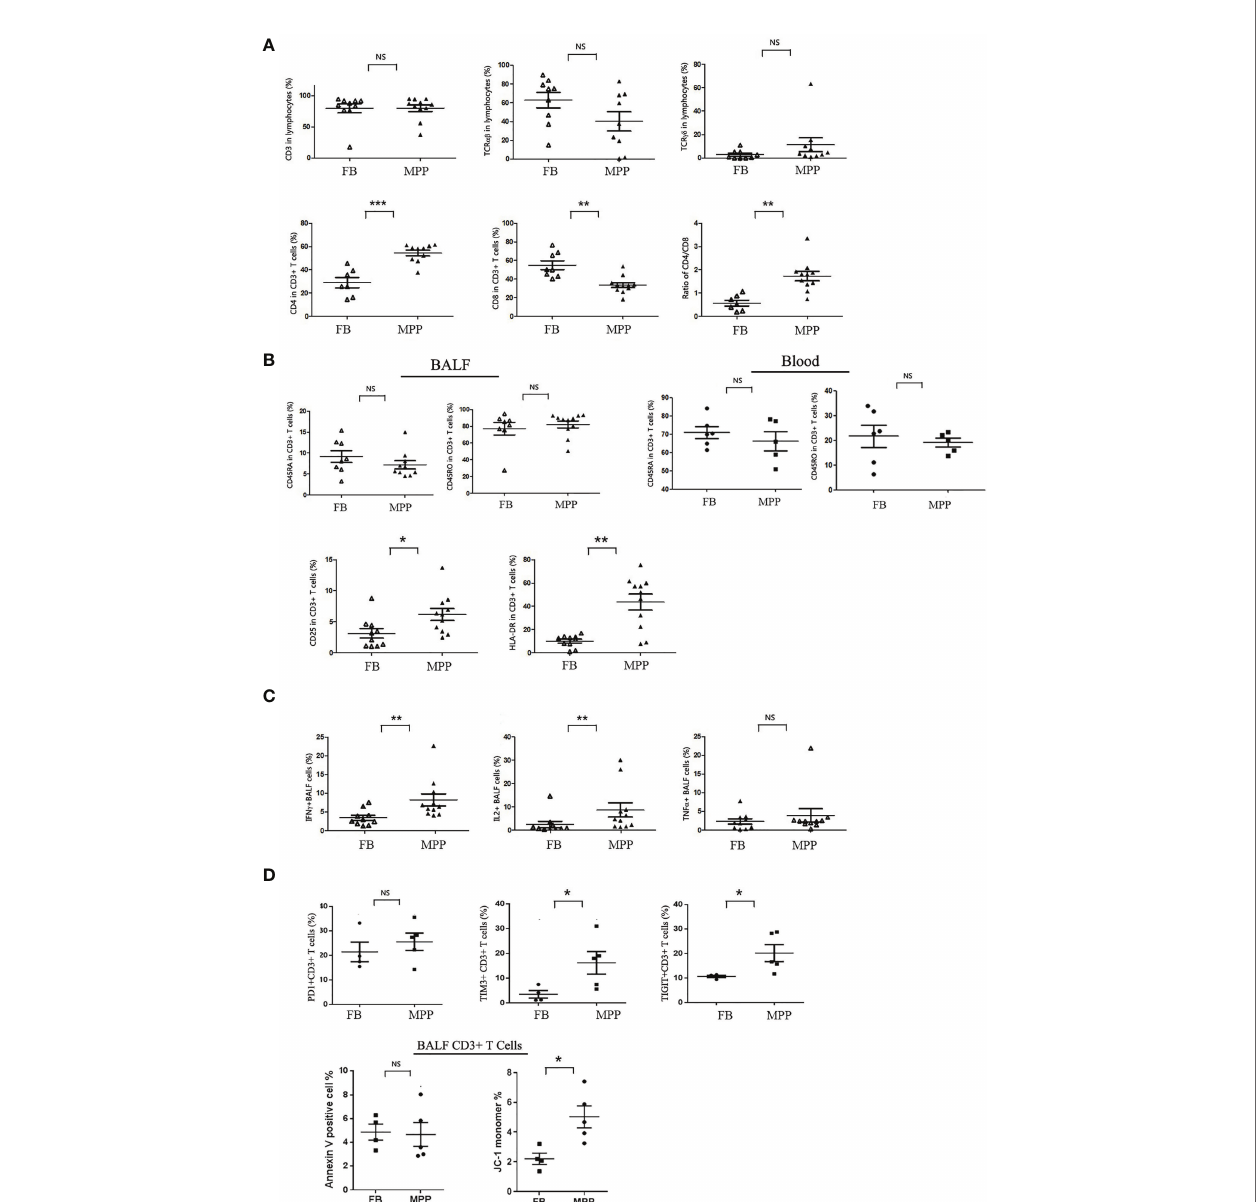
FIGURE 1 | BALF cells from patients (MPP) and controls (FB) were stained with monoclonal antibodies conjugated with fl ourochrome. Cells were washed with PBS and then subjected to the analysis by a FACScalibur fl ow cytometry. Data were processed with Flowjo software. Every dot in the scatter plot indicates a patient or control sample. * p < 0.05; ** p < 0.01; *** p < 0.001; NS, no signi fi cant difference. (A) T-cell subgroups and CD4/8 ratio were represented as scatter plots. (B) Cytometric analysis of naive (CD45RA+) vs. memory (CD45RO+) in BALF and blood CD3+ cells, as well as the activation status (CD25+ and HLA-DR+) of BALF T cells (gating CD3+ population). (C) BALF cells were stimulated with TCR ligation by anti-CD3/CD28 in the presence of Golgi Stop. Intracellular cytokines (IFN- g , IL-2, and TNF- a ) expression was detected with corresponding fl ourochrome-conjugated antibody following cell perforation. (D) BALF cells from MPP patients and FB controls were stained with PD1, TIM3, and TIGIT; their ratio in CD3+ T-cell gate was represented (upper panels). BALF cells from MPP patients and FB controls were stained with annexin V and JC-1 for apoptosis analysis. The ratios of annexin V-positive cells and JC-1 monomer + cells in CD3+ T-cell gate were represented as dot